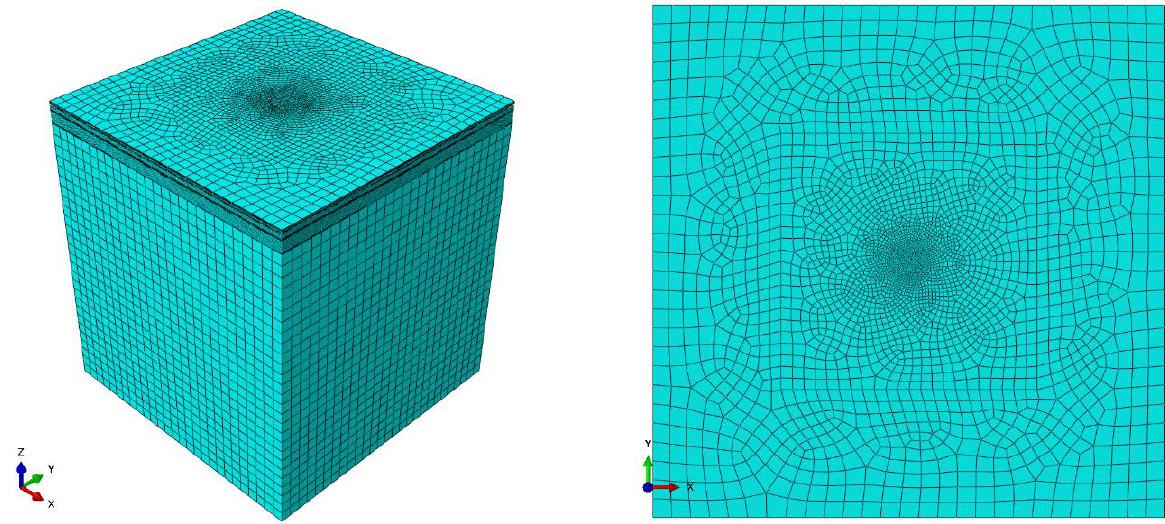
Figure 8. Mesh in designed model.